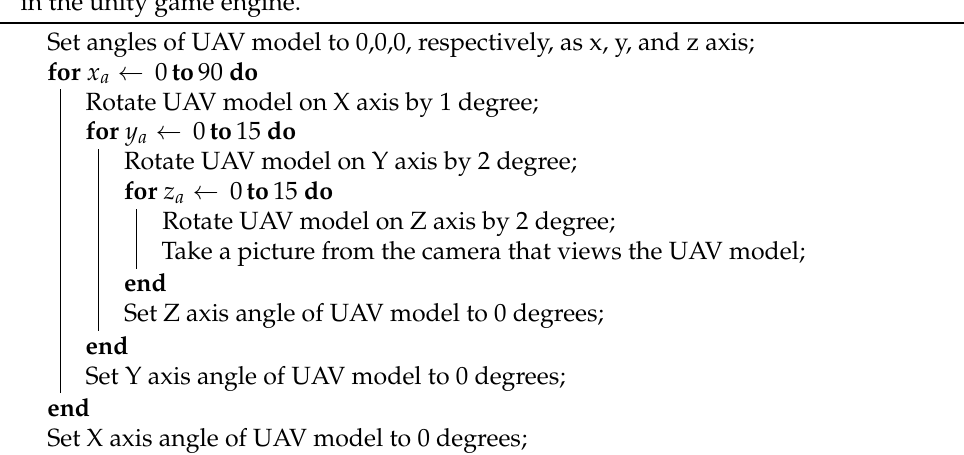
Figure 2. Green box studio designed in the unity game engine environment: ( a ) Virtual camera used to take a picture. ( b ) RW-UAV 3D model. ( c ) Light sources to generate realistic pictures. ( d ) Green-colored background, wall view. ( e ) Example camera view. Algorithm 1: RW-UAV model rotation and synthetic image generator